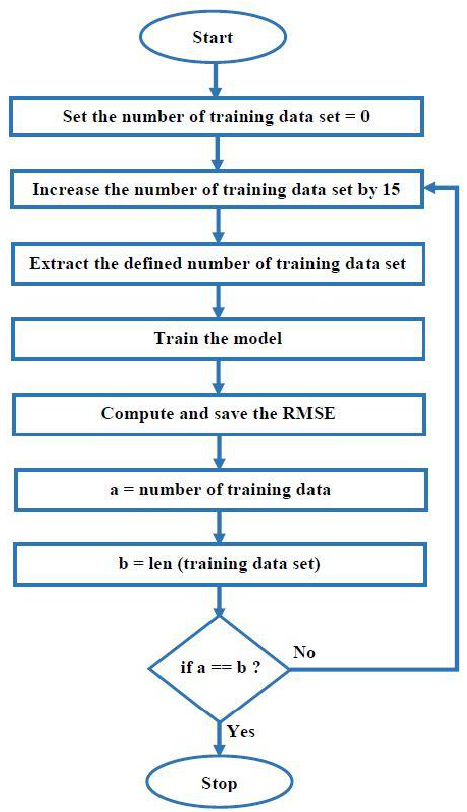
Figure 3. Flow chart of the optimization process.